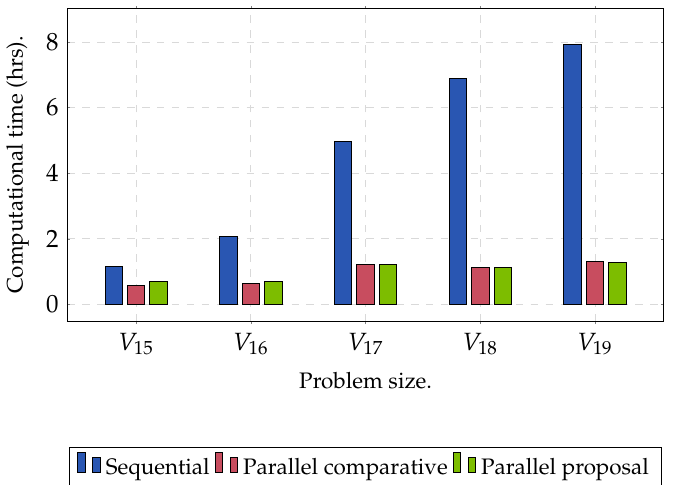
Figure 3. Performance for the number of executions by the NMF Algorithm with fine-grained parallelization. For this implementation, a set of matrices built in silico was used ( V 15 ∈ R 57,44 , V 16 ∈ R 219,46 , V 17 ∈ R 250,200 , V 18 ∈ R 3500,50 , V 19 ∈ R 5000,38 ). For the experiments, we defined T = 1000 and (cid:101) = 10 − 12 was set. In addition, we established the range of K between [ 2,10 ] . In all cases, the matrix was squared. We used a processor Xeon E5-1603 v3 with four cores, an operating system based on Ubuntu v.18.04, and CUDA v.10.2. Consider that an ext4 filesystem and a SATA HDD were used. Moreover, we used an NVIDIA Quadro RTX 4000 GPU with 2304 cores and 8 GB of DDR6 RAM (Turing